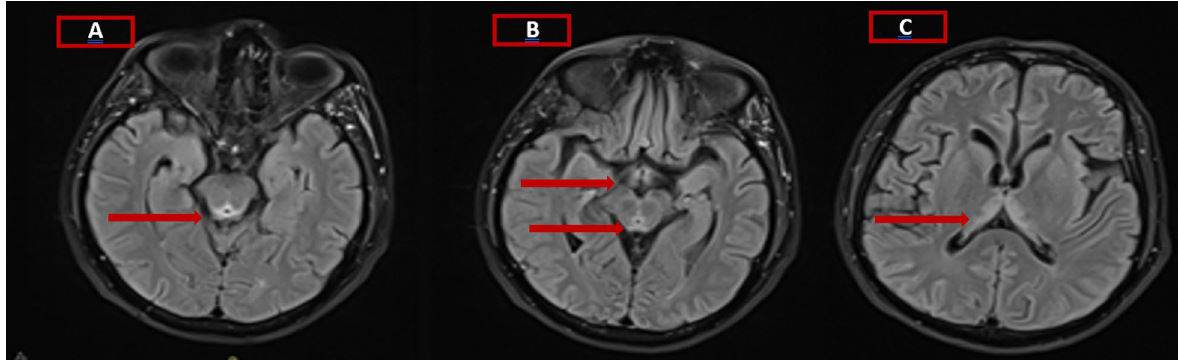
Fig. 1 Brain magnetic resonance imaging (T2-FLAIR sequences). Axial sections on T2-FLAIR sequences showing hyperintense signaling in the periaqueductal area ( A , B ), in mammillary bodies ( B ) and in medial thalamic nuclei ( C